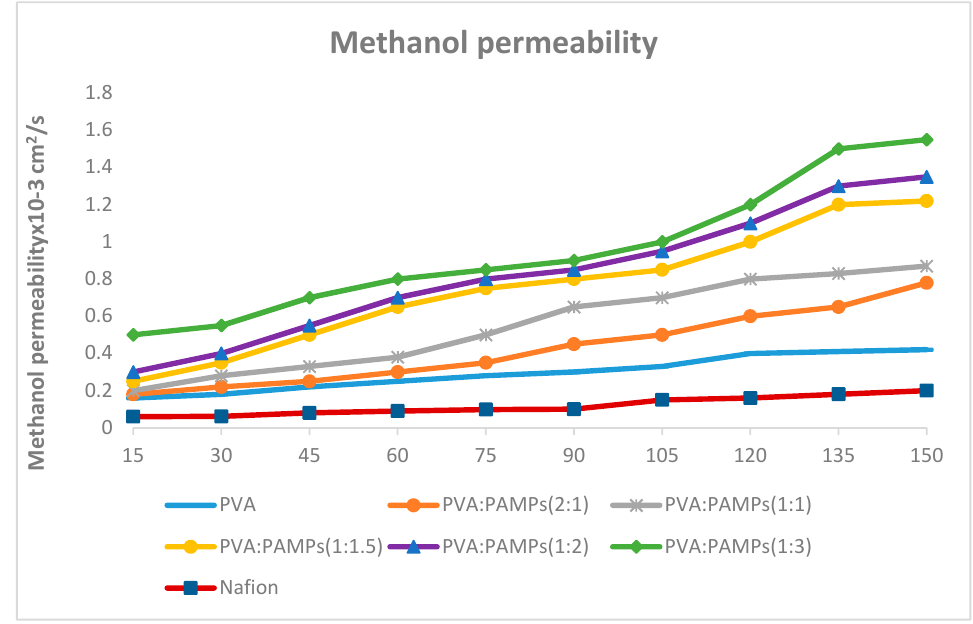
Figure 4. Amount of permeated methanol as a function of time for PVA and PVA/PAMPS blended membrane.